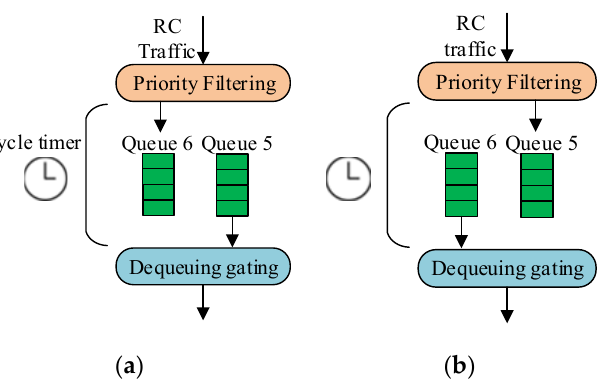
Figure 3. The implementation of the CQF mechanism: ( a ) odd time slot; ( b ) even time